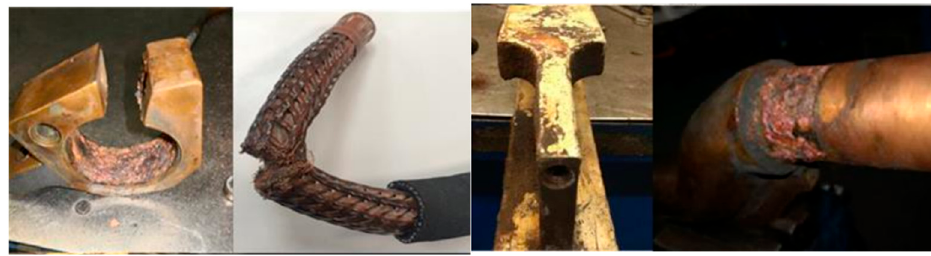
Figure 2. Typical wear in secondary circuit